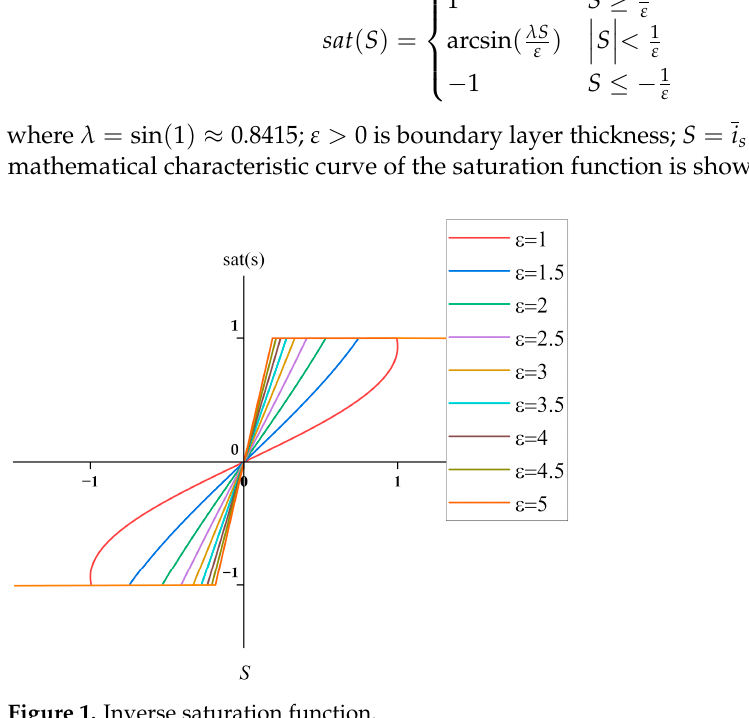
Figure 1. Inverse saturation function.